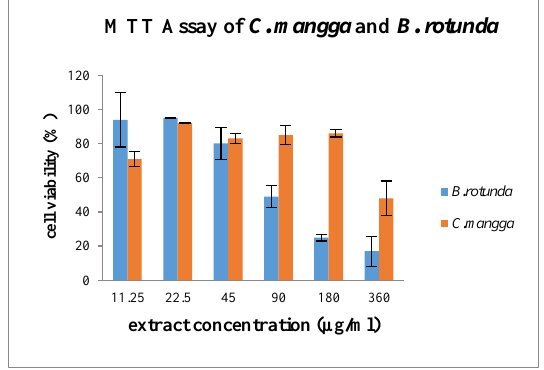
Figure 4.: Graph of cell viability by two extract treatments; B. rotunda and C.